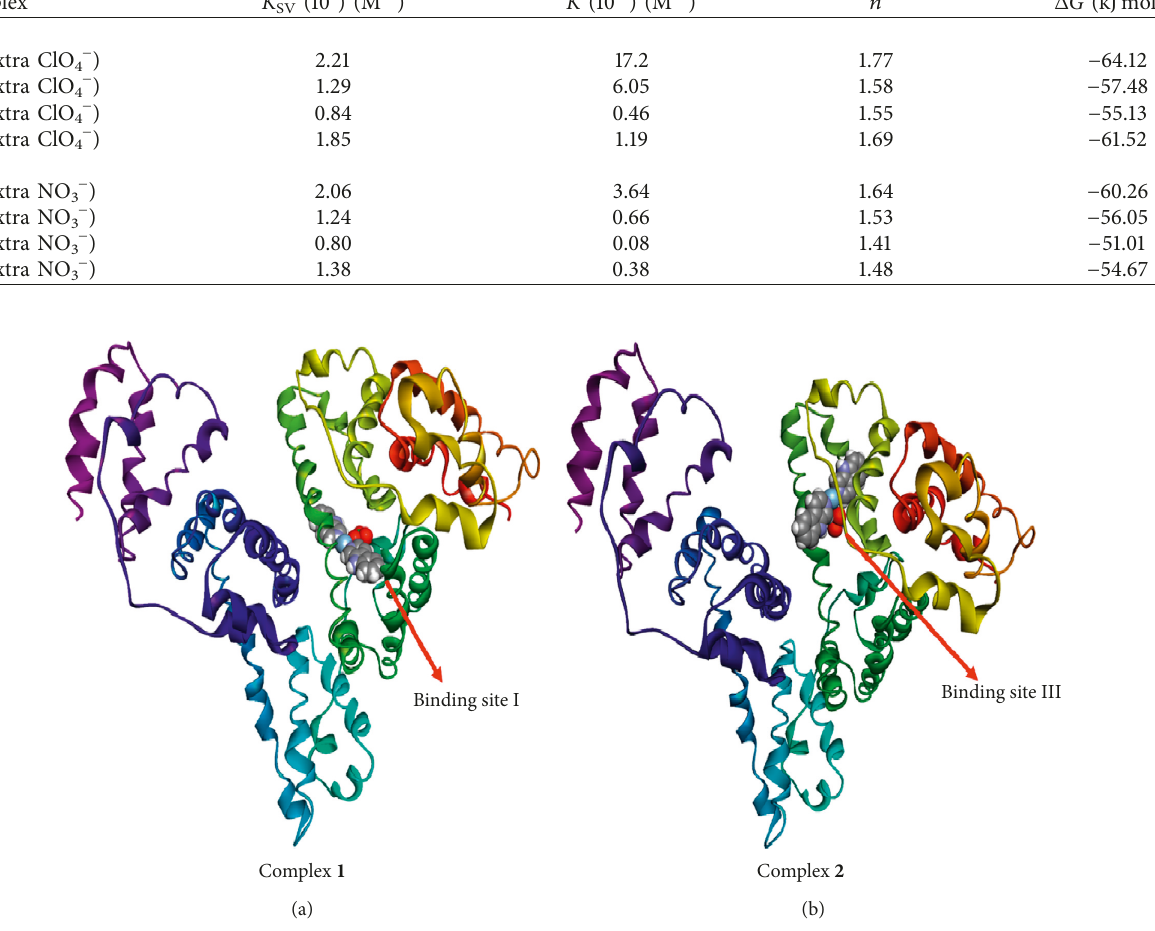
Figure 8: Binding of compounds (a) 1 and (b) 2 at different binding sites of